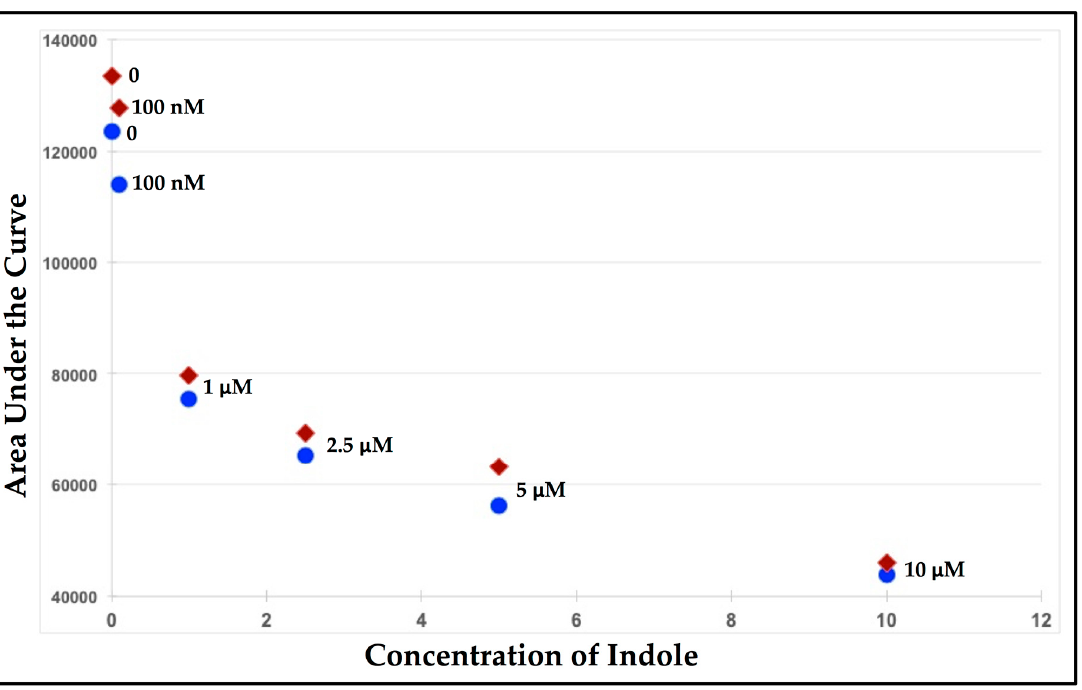
Figure A1. Response of AgamOBP1 to various dilutions of indole using the Attenu assay. Concentrations of indole including, from left to right, 0, 100 nM, 1 µM, 2.5 µM, 5 µM, and 10 µM were tested with the Attenu assay. Shown on the plot are two separate experiments run with the same indole dilutions. The first experiment is shown as blue circles, the second as red diamonds. Note that a drop in response is visible even at 100 nM.